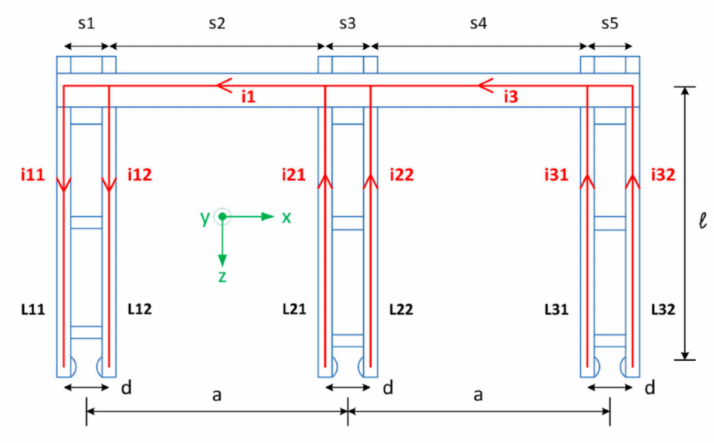
Figure 13. Top view of the earthing switch—red lines represent current lines; s1–s5 represent segments for force calculation on conductors at right angles; L11-L32 represent designations of each earthing knife